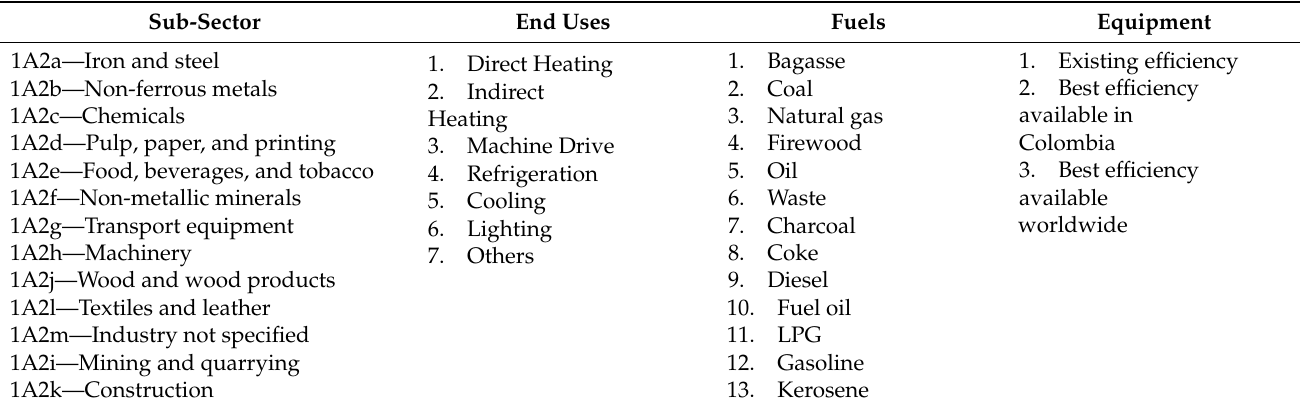
Table 2. Industry structure by